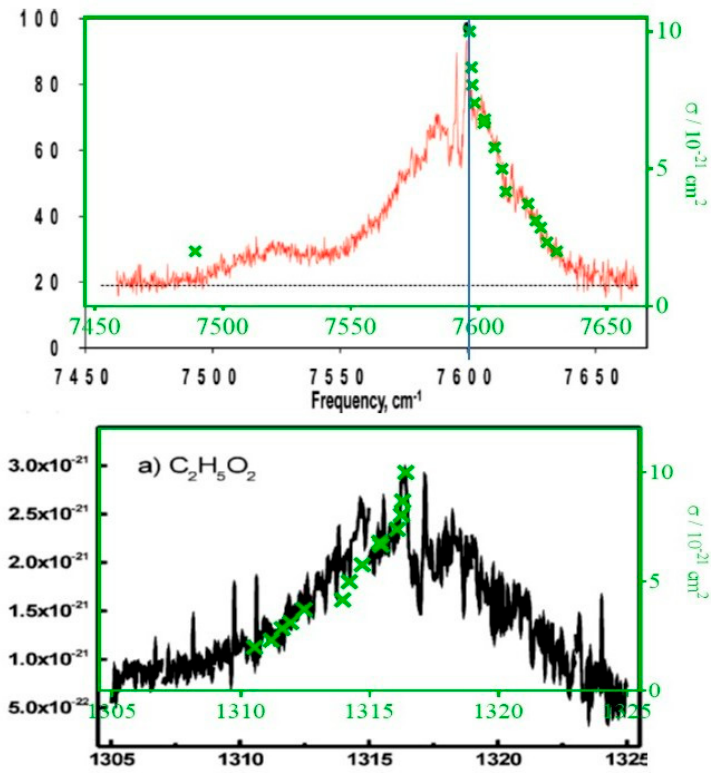
Figure 7. C 2 H 5 O 2 absorption coefficients at different wavelengths obtained in this work (green crosses and green axis), overlaid onto the spectrum obtained by Melnik et al. [17] (upper graph, Reprinted with permission from [17], Copyright 2010 American Chemical Society) and Atkinson and Spillman [11] (lower graph, Reprinted with permission from [11], Copyright 2002 American Chemical Society). In the upper graph the data have been shifted by 4 cm − 1 , and in both graphs our